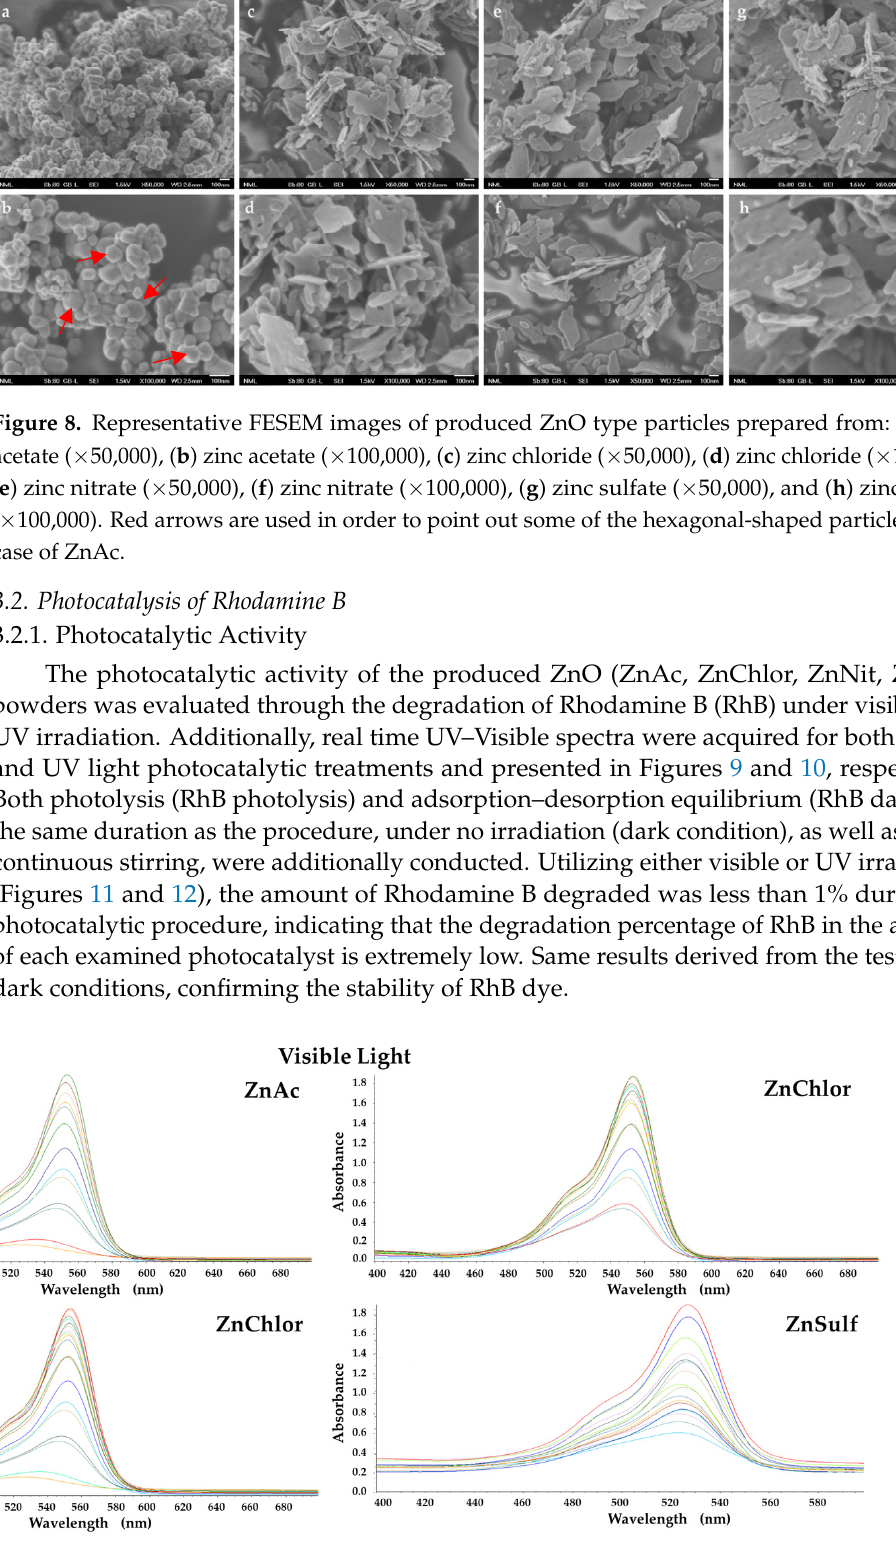
Figure 10. Real time UV–Visible spectra under UV photocatalytic degradation of Rhodamine B, by the four ZnO powders, produced by different precursors.